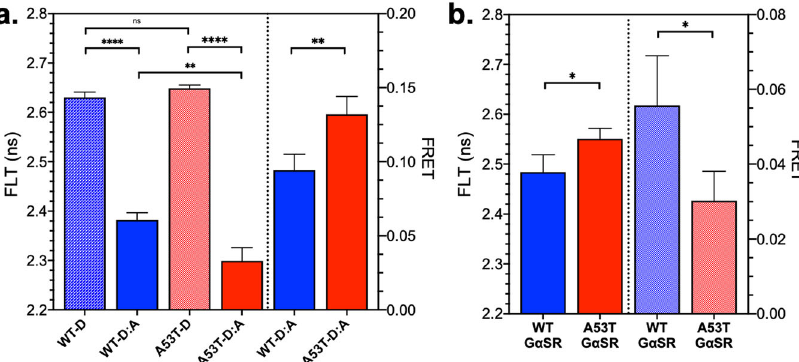
Fig. 3 Characterization of α SN cellular FRET biosensors. a Comparison of WT and A53T α SN inter-protomeric FRET biosensors show decreased fl uorescence lifetime and corresponding increased FRET for the aggregation-prone A53T construct relative to WT. b Comparison of WT and A53T α SN intra-protomeric FRET biosensors shows an increased fl uorescence lifetime and decrease in FRET for the A53T relative to WT. Experiments were done with n = 5; * p < 0.05, ** p < 0.01, **** p < 0.0001, ns indicates no signi fi cant difference as determined by Student ’ s t